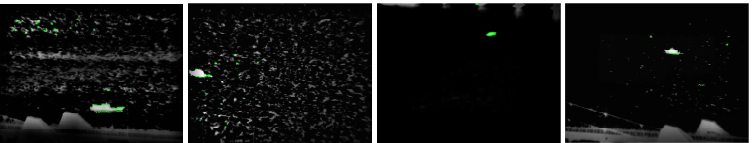
Figure 7. Preprocessed results of images in Figure 1a–d, respectively.